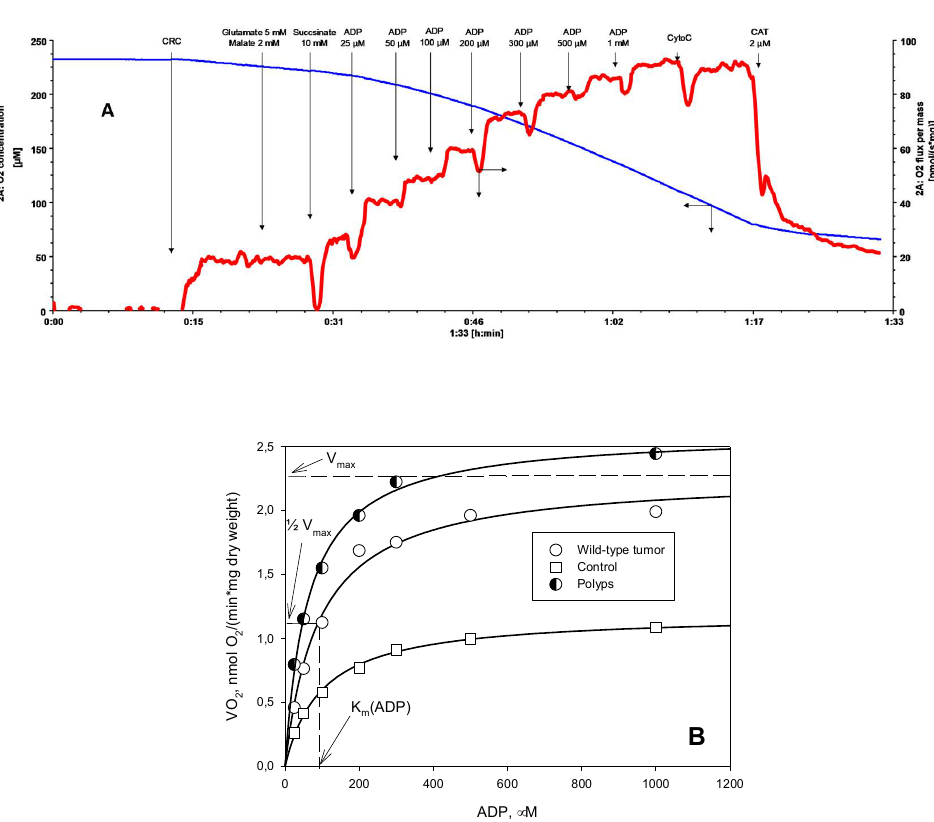
Figure 3. Different kinetics of regulation of mitochondrial respiration by exogenous ADP in colon tissue. ( A ) Recording of original traces of O 2 consumption by permeabilized colorectal cancer (CRC) tissue upon additions of increasing concentrations of ADP. CAT stands for carboxyatractyloside; CyoC stands for cytochrome C. (B) The measured respiration rates were plotted vs ADP concentrations, and from this plot corresponding V max and K m (ADP) values were calculated by nonlinear regression using Michaelis–Menten equation. There was a marked difference in ADP kinetics between wild-type CRC, colon polyps and normal colon tissue (control).